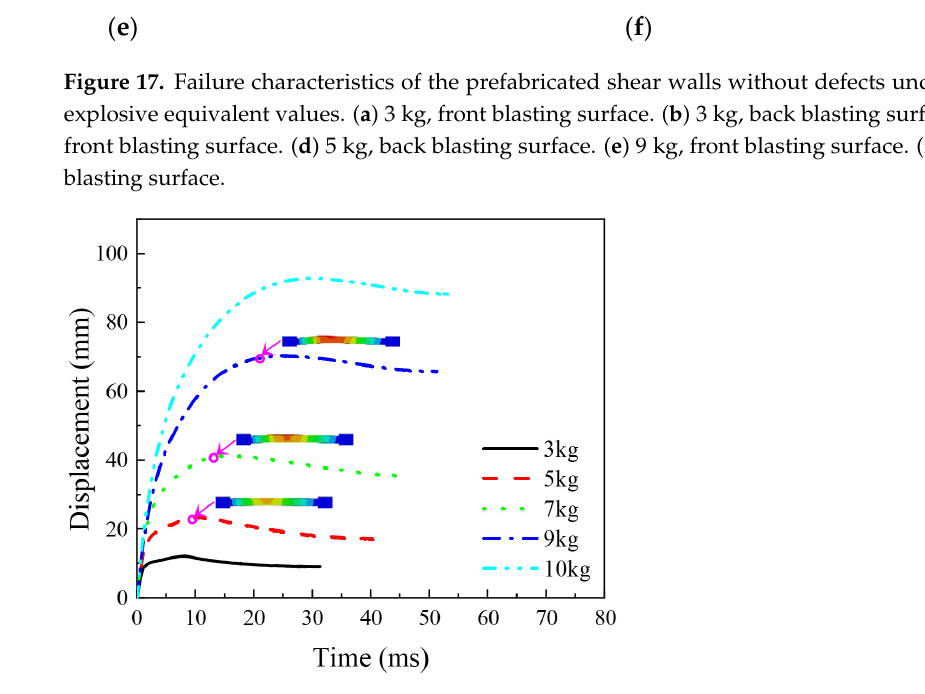
Figure 20 2. Please delete the redundant oval in Figure 21(b). If it is inconvenient to delete, please replace Figure 21 (b) with the correct one in this document. The WRONG Figure: The CORRECT Figure: Please delete this oval.